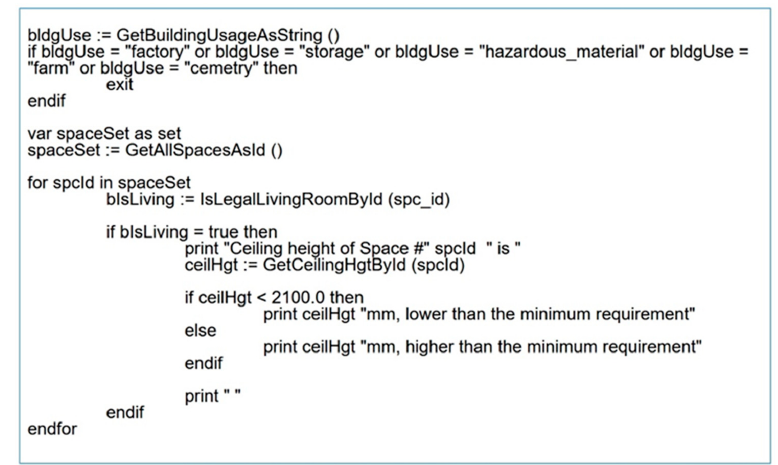
Figure 9. Example of rule-based quality checking results according to design check criteria (e.g., installation of ceiling). 6. Usage and Verification of Proposed Quality Checking Requirements 6.1. Overview In this section, a quality check of BIM data was performed to validate the applicability of the developed quality check criteria, by using rule-based quality check software. Some of the criteria for space and construction checks were established based on modifications to the basic rules supported by SMC, as previously mentioned. For the design check criteria, heat loss prevention criteria were additionally developed, and these also were adopted in quality checks. Revit and ArchiCAD were used as the BIM software. The properties of regulation information in the design criteria were input